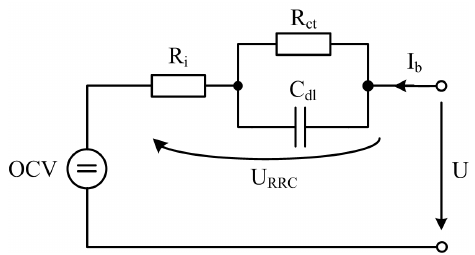
Figure 1. Selected model for the lead-acid